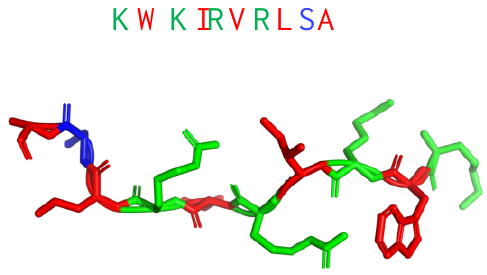
Figure 22. Secondary structure of lin-SB056-1 calculated with I-Tasser. In blue: hydrophilic amino acids; in green: positively charged amino acids; in red: hydrophobic amino acids.